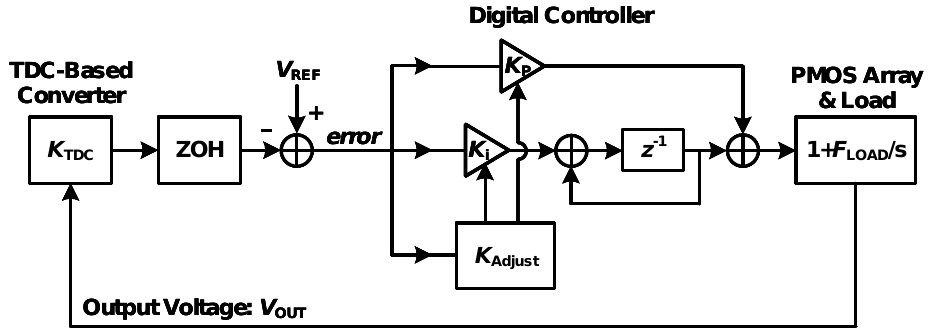
Figure 2. The system hybrid model for the proposed D-LDO.